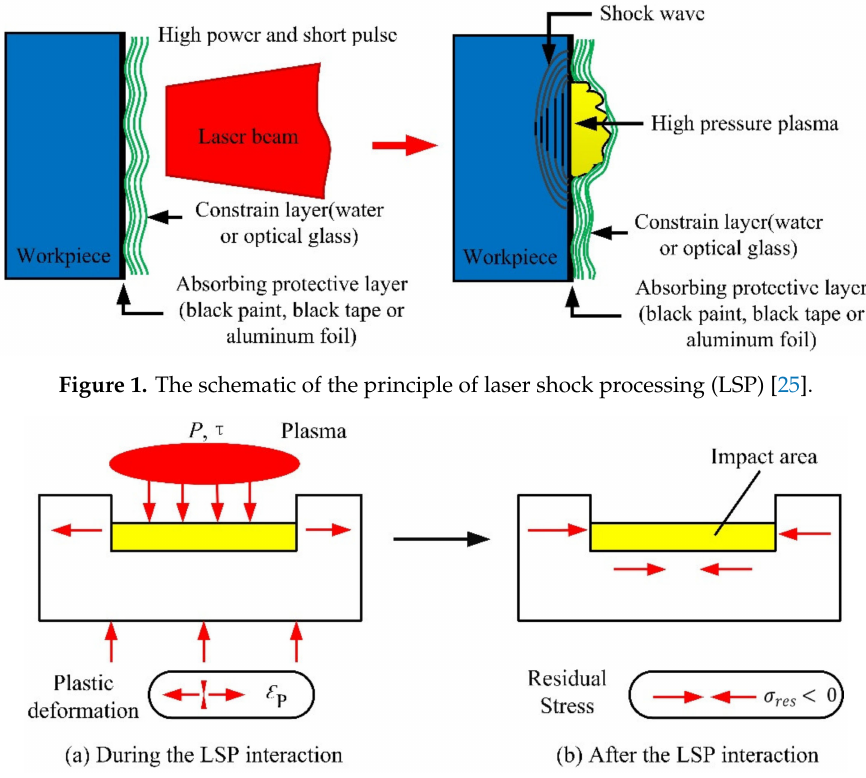
Figure 2. The schematic diagram of compressive residual stress induced by LSP